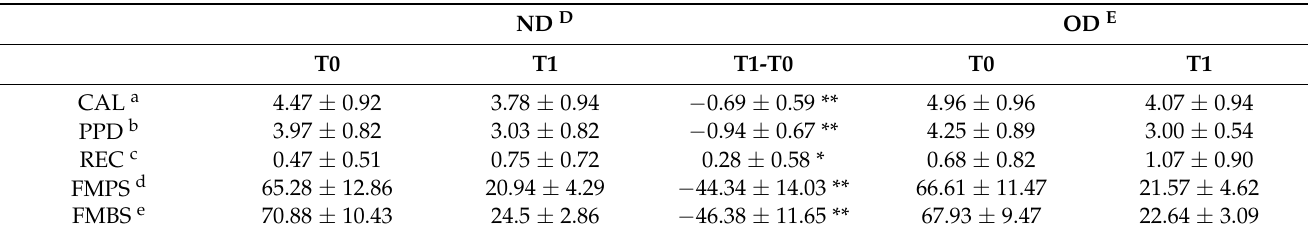
Table 3. The periodontal markers, as measured at baseline after six months and the difference between the two values.